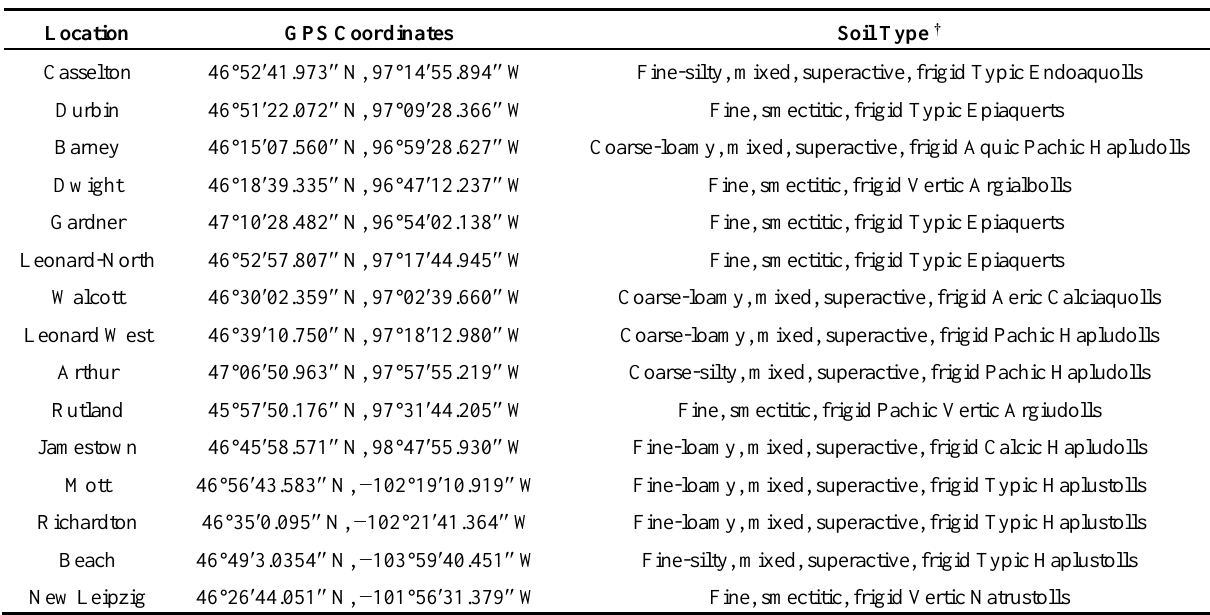
Table 1. GPS coordinates and soil series for field experiments in 2013.